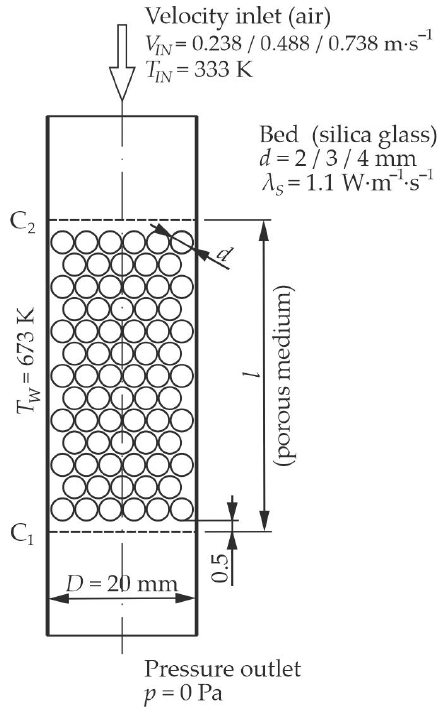
Figure 1. Schematic of modeled fixed-bed reactor. In order to emphasize the influence of the phenomena occurring near the reactor walls and the tunneling effect, the spheres in the bed were not arranged randomly, but in a specific order. In the core of the reactor, the spheres were placed on the tops of the tetrahedron, while the vicinity of the reactor walls remained unfilled, with the width of these slots resulting from the total number of balls in the row. To ensure the high quality of the mesh elements, the balls were moved apart by a constant value of 0.2 mm. This way, for each of the three diameters of spheres, three variants of geometry consisting of 5, 9, and 13 layers were built (see Figure